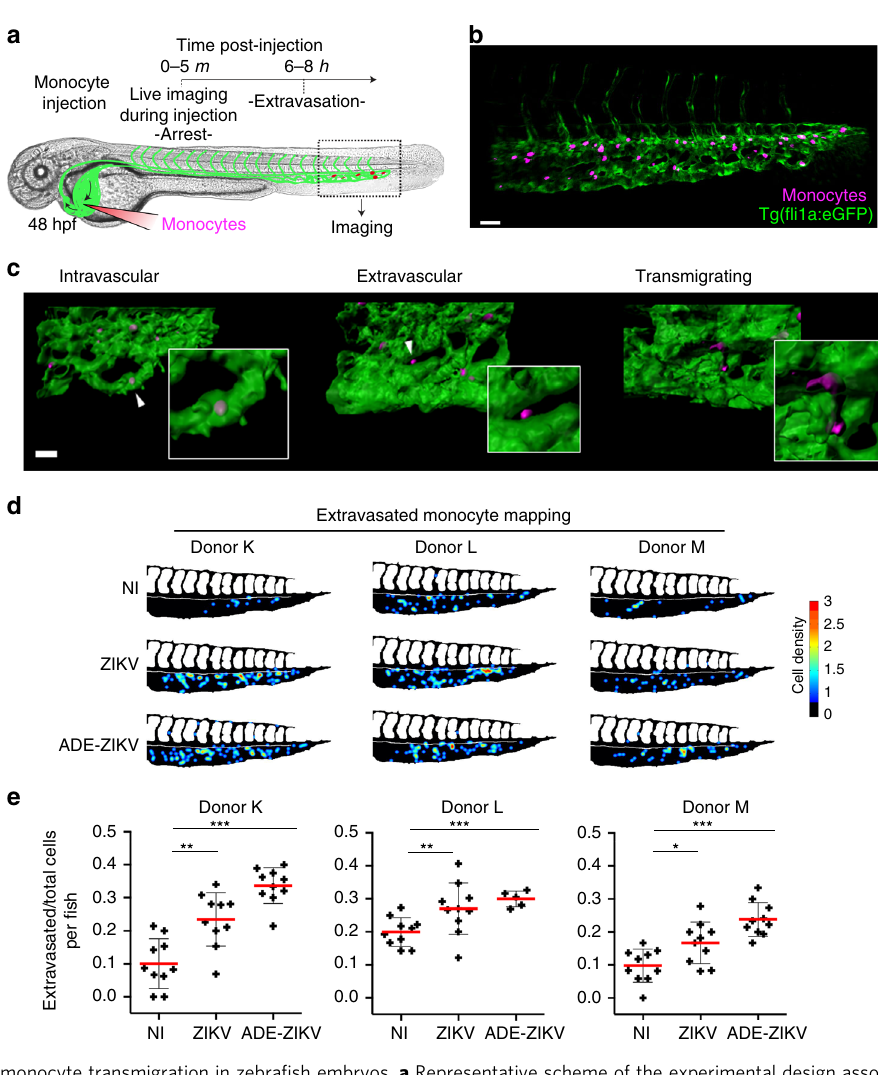
Fig. 7 ZIKV enhances monocyte transmigration in zebra fi sh embryos. a Representative scheme of the experimental design associated with the zebra fi sh model. Human primary monocytes were noninfected (NI), or infected for 48 h with ZIKV in the absence (ZIKV) or presence (ADE – ZIKV) of 20 ng/mL of the 4G2-enhancing pan- Flaviviridae antibody (see Supplementary Fig. 10), stained with CellTrace, and injected into the duct of Cuvier of Tg( fl i1a:eGFP) zebra fi sh embryos (GFP-labeled endothelial cells 44 ). b Zebra fi sh imaging was done at 6 – 8 h post injection by scanning confocal microscopy. Representative 3D confocal image of the monocytes ’ distribution within the tail of a zebra fi sh embryo vasculature (associated with